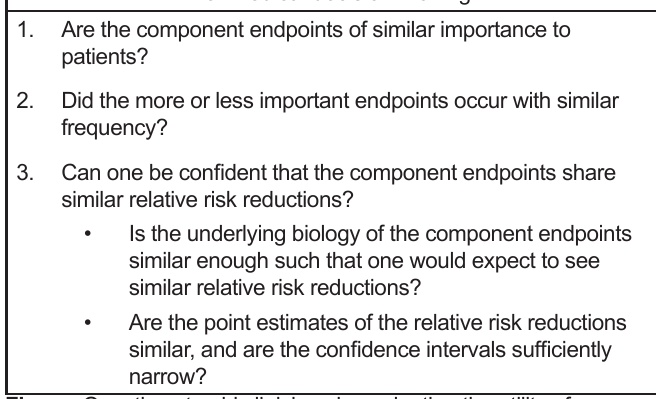
Figure. Questions to aid clinicians in evaluating the utility of a composite endpoint as a basis for medical decision-making (for therapies purported to decrease the risk of an undesirable